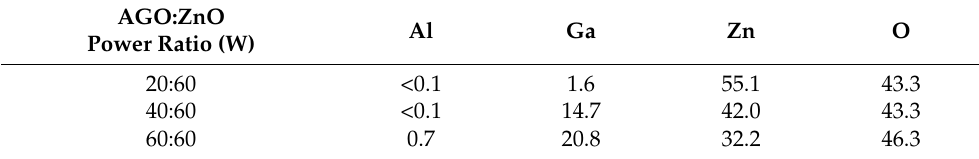
Figure 3. Transmittance spectra of 100-nm AGZO films and the inset is the Tauc plot (the mark represents the power ratio of AGO:ZnO). Table 1. Element composition of AGZO thin film with different co-sputtering